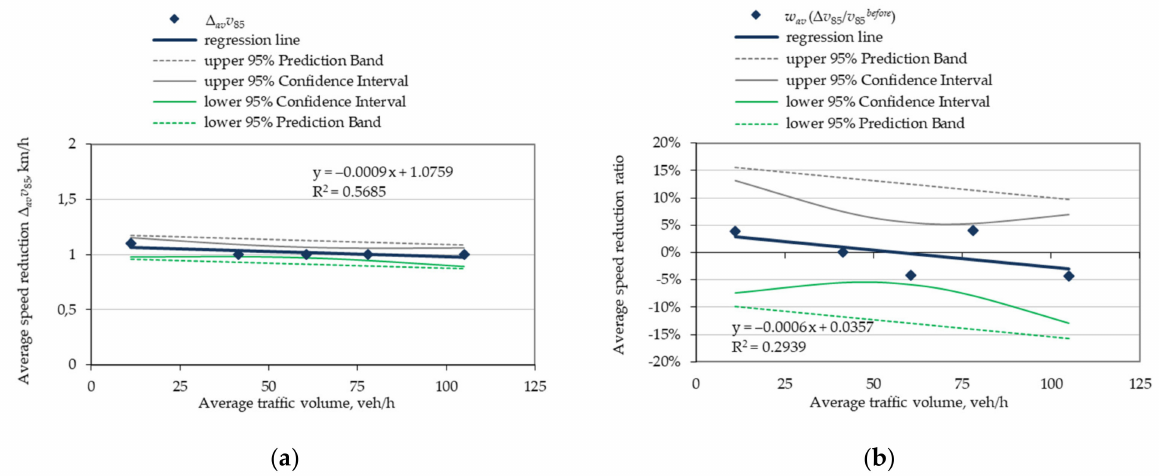
Figure 15. Regression analyses (testing ground No. 2) for the following relationships: ( a ) average reduction in free-flow speed ∆ v 85 and average traffic volume ( R = − 0.75); ( b ) speed reduction ratio and average traffic volume ( R = − 0.54). Source: own work of the